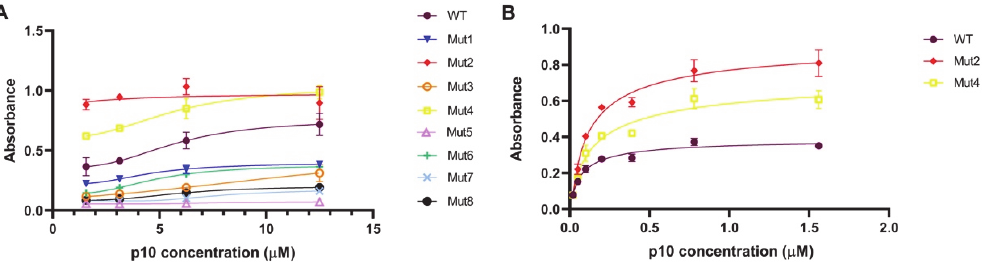
Figure 8. ELISA assay quantifying the dsDNA-binding affinity of M1–8 mutants ( A ) and at lower concentrations of M2 and M4 ( B